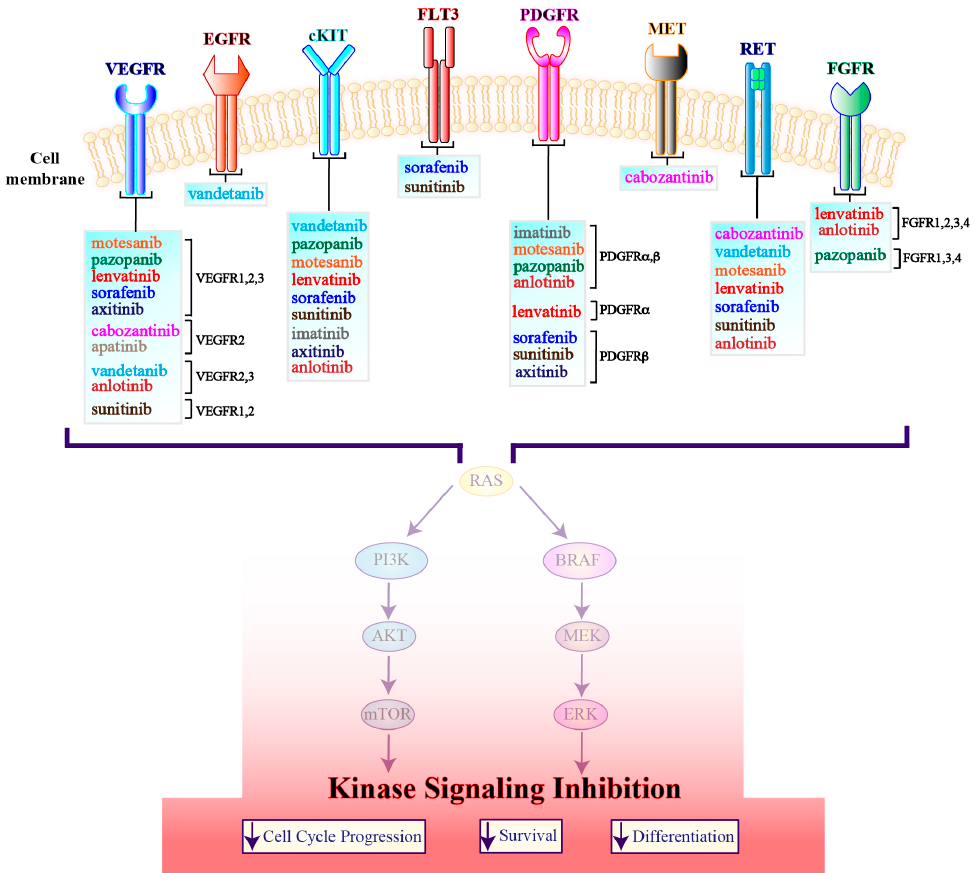
Figure 4. A working model describing vertical inhibition of cell cycle progression, survival and differentiation by agents targeting tyrosine kinase receptors. Multi-targeted kinase inhibitors included in each box have been investigated in thyroid cancer and are cataloged according to their receptor kinase specificity and selectivity. VEGFR, vascular endothelial growth factor receptor; EGFR, epidermal growth factorreceptor; c-KIT,Mast / StemCellGrowthFactorReceptorKit; FLT3, FMS-liketyrosinekinase3; PDGFR, platelet-derived growth factor receptor; MET, proto-oncogene, receptor tyrosine kinase; RET, rearranged during transfection; FGFR, fibroblast growth factor receptor; PI3K, phosphoinositide 3-kinase; AKT, V-Akt Murine Thymoma Viral Oncogene Homolog; mTOR, Mammalian Target of Rapamycin; BRAF, B-Raf proto-oncogene; MEK, Mitogen-Activated Protein Kinase; ERK, Extracellular Signal-Regulated